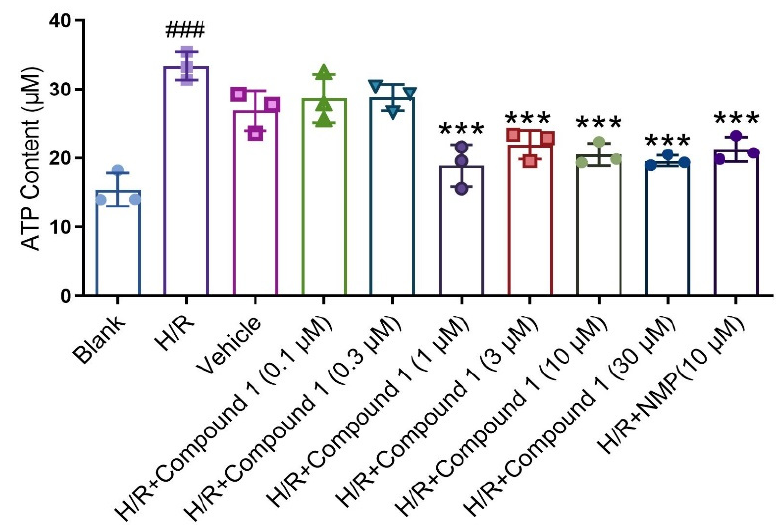
Figure 4. ATP Content. Data represent mean ± SD (*** p < 0.001, vs. H/R Group; ### p < 0.001, vs. Blank Group).